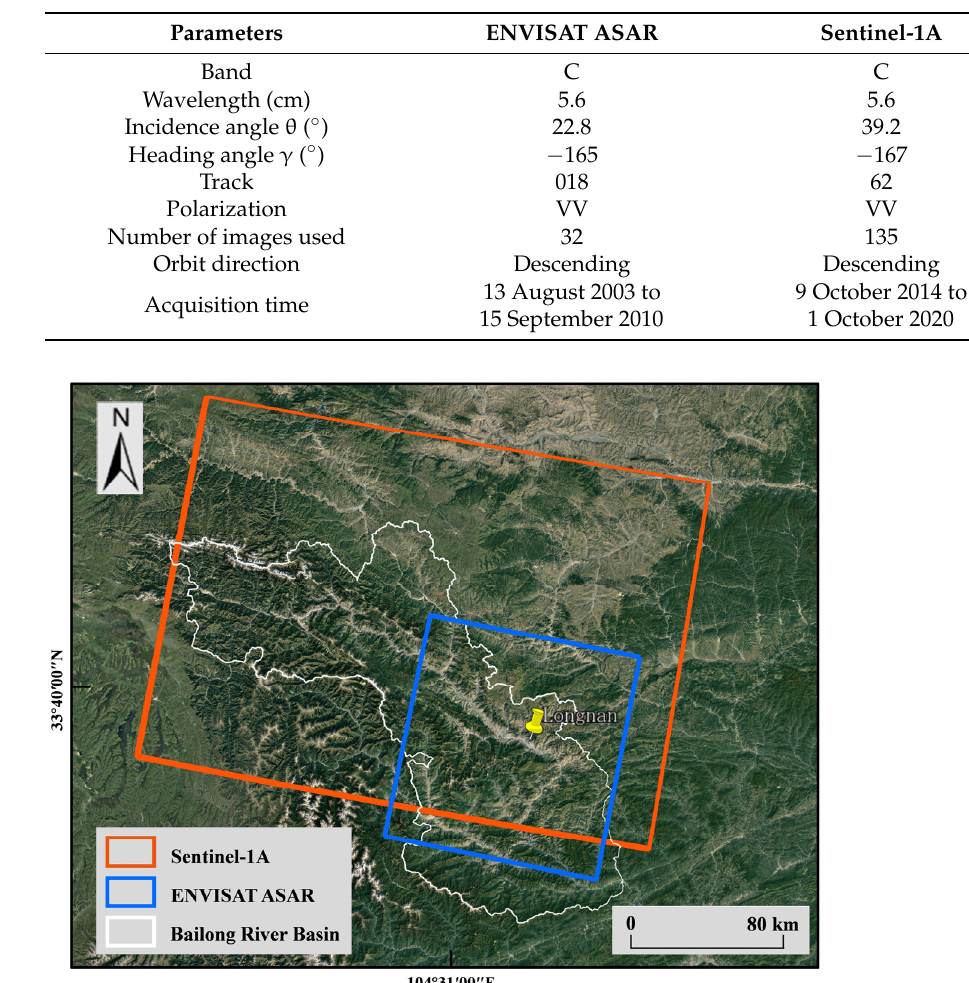
Table 2. ENVISAT ASAR data and Sentinel-1A data information. Table 3. Annual precipitation data of the study area.